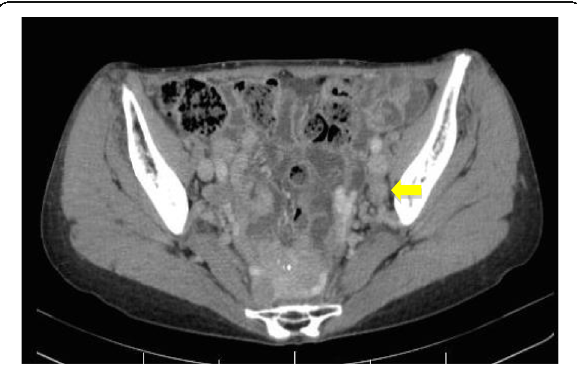
Fig. 3 Abdominal CT scan 12 months after surgery showed a lymph node swelling at the left external iliac region (arrow)